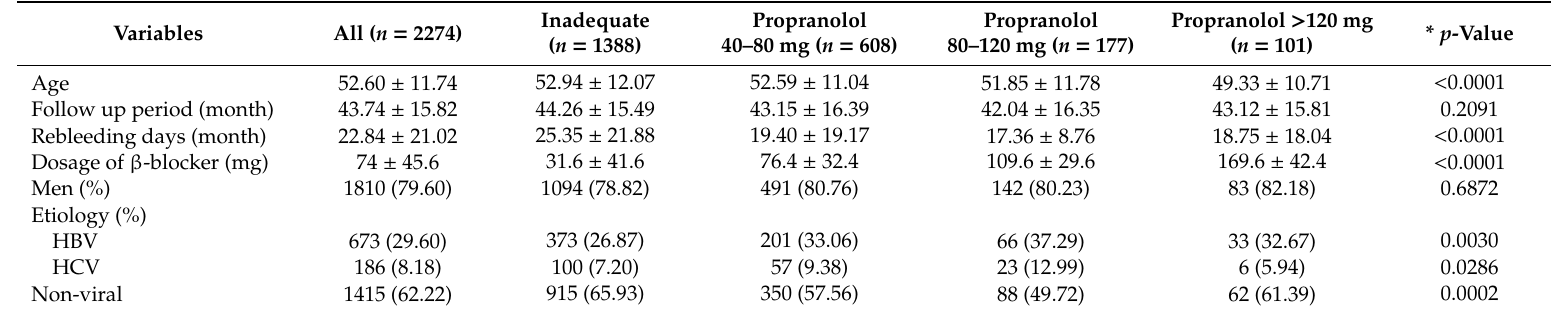
Table 1. Basic characteristics of